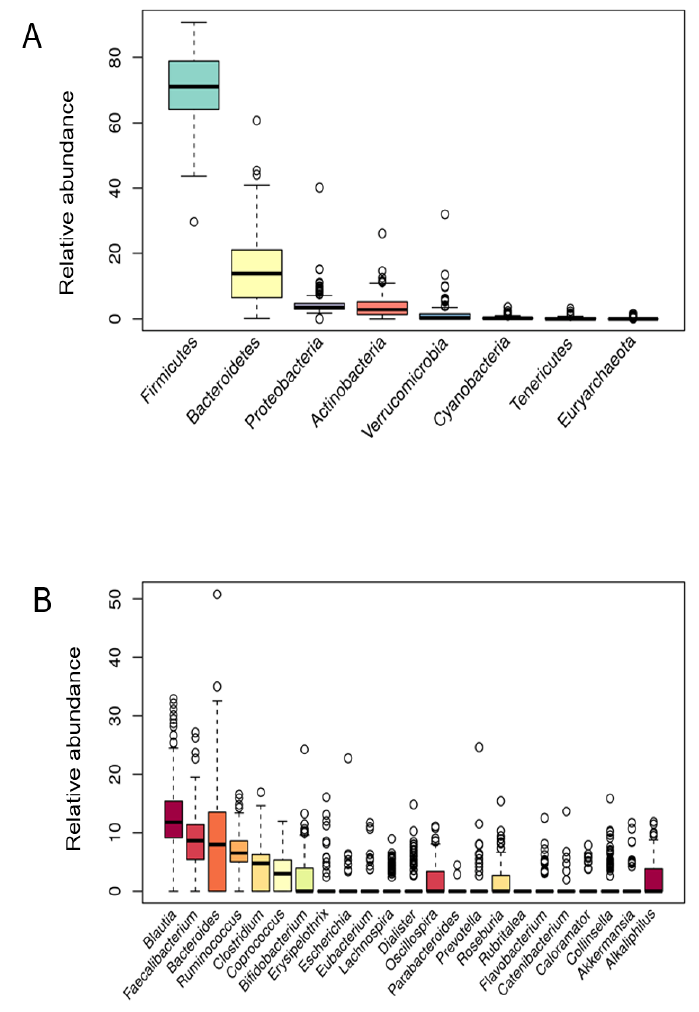
Figure 1. Bacterial phyla ( A ) and genera ( B ) relative abundance.